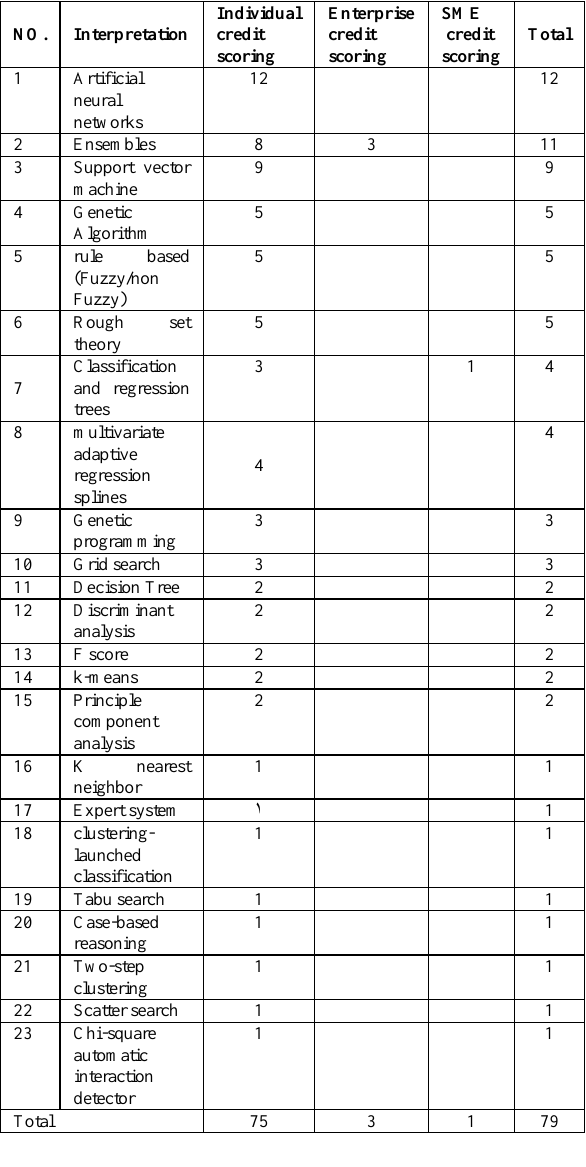
Table 4. Distribution of articles by journal